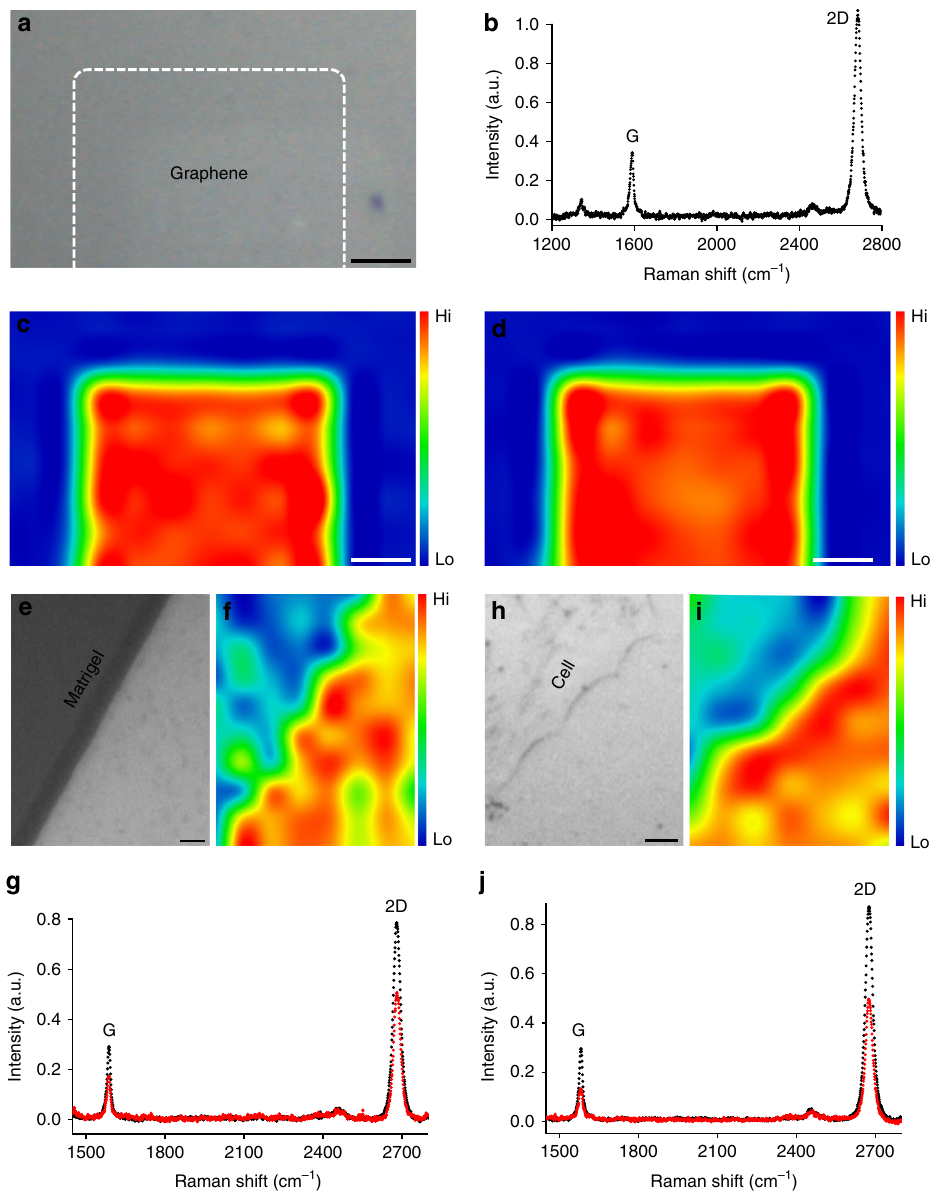
Fig. 2 Characterization of graphene fi lms. a Bright fi eld image shows the fi eld of view. Scale bar, 1 mm. b Raman spectrum at the graphene-covered area shows characteristic G and 2D peaks. The high 2D vs. G ratio and a symmetric 2D peak are consistent with those of monolayer graphene. Corresponding spatially resolved map of c Raman G-peak intensity and d 2D-peak intensity from the same fi eld of view. Scale bar, 1 mm. e Bright fi eld image shows the edge of a Matrigel droplet (upper-left) on a graphene-coated glass coverslip. f Corresponding Raman 2D-peak intensity map. Scale bar, 5 μ m. g Raman spectrum of the bare graphene area (black) shows a high 2D vs. G ratio and a symmetric 2D peak, indicating monolayer graphene. At the Matrigel-coated graphene area (red), there is a strong reduction of intensity of both the G and 2D peaks. h Bright fi eld image shows the edge of a cell (upper left) growing on a graphene-coated glass coverslip. i Corresponding Raman 2D-peak intensity map. Scale bar, 5 μ m. j Raman spectrum at the cell-covered graphene area (red) also exhibits an intensity reduction for both G and 2D peaks in comparison with that at the bare graphene area